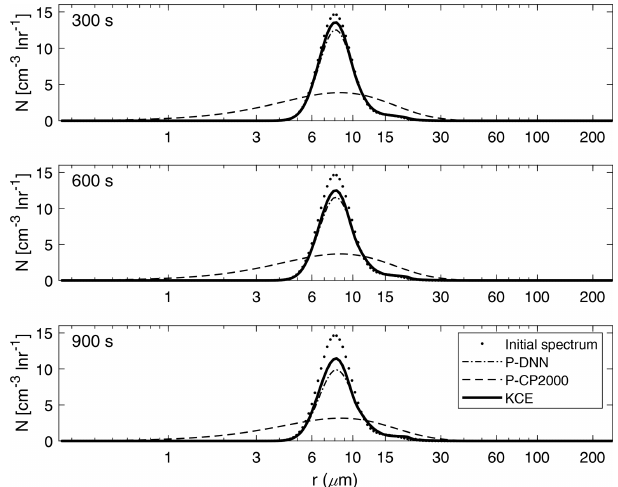
Figure 9. Drop number concentration (a) and mean radius (b) com- parison with KCE. The concentration and mean radius of KCE were obtained by integrating the drop number concentration spectra for the corresponding moment order (0 and 1, respectively). The data points are plotted every